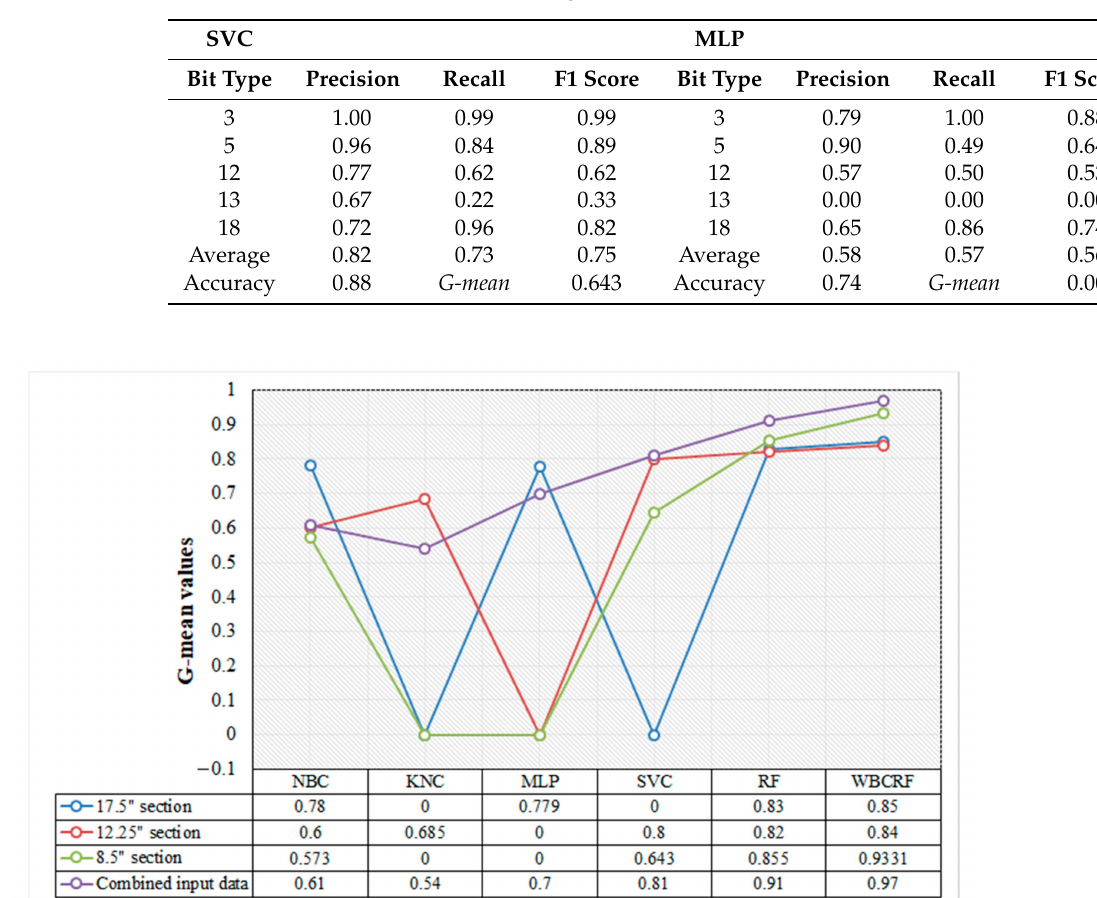
Table 15. The selection of 8.5” bits through SVC and MLP classifiers.